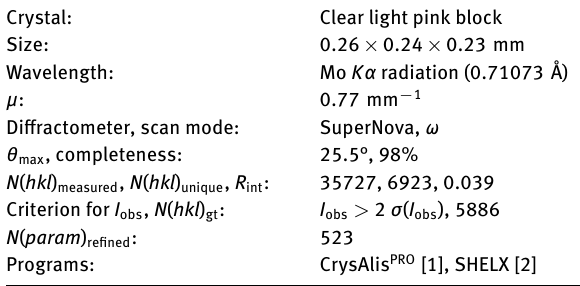
Table 2: Fractional atomic coordinates and isotropic or